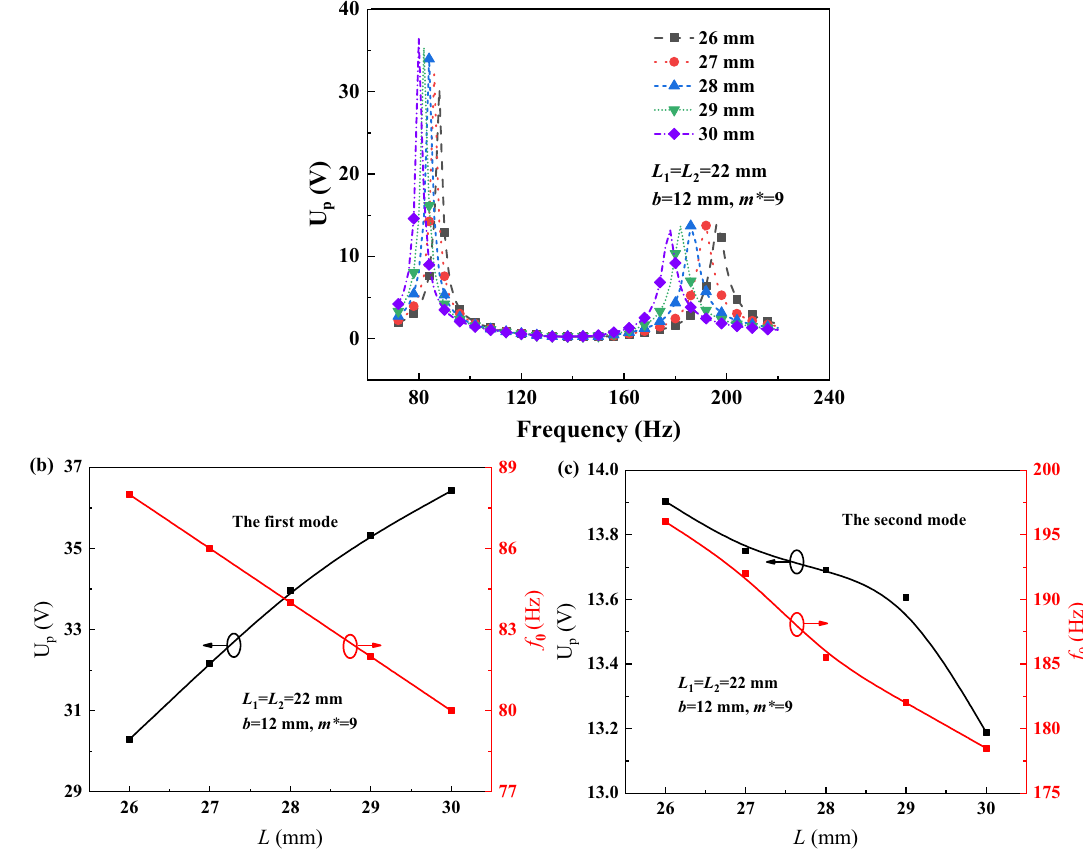
Figure 6. The U p - f curves ( a ), the U p-max and f 0 vs L curves at the first ( b ) and second ( c )